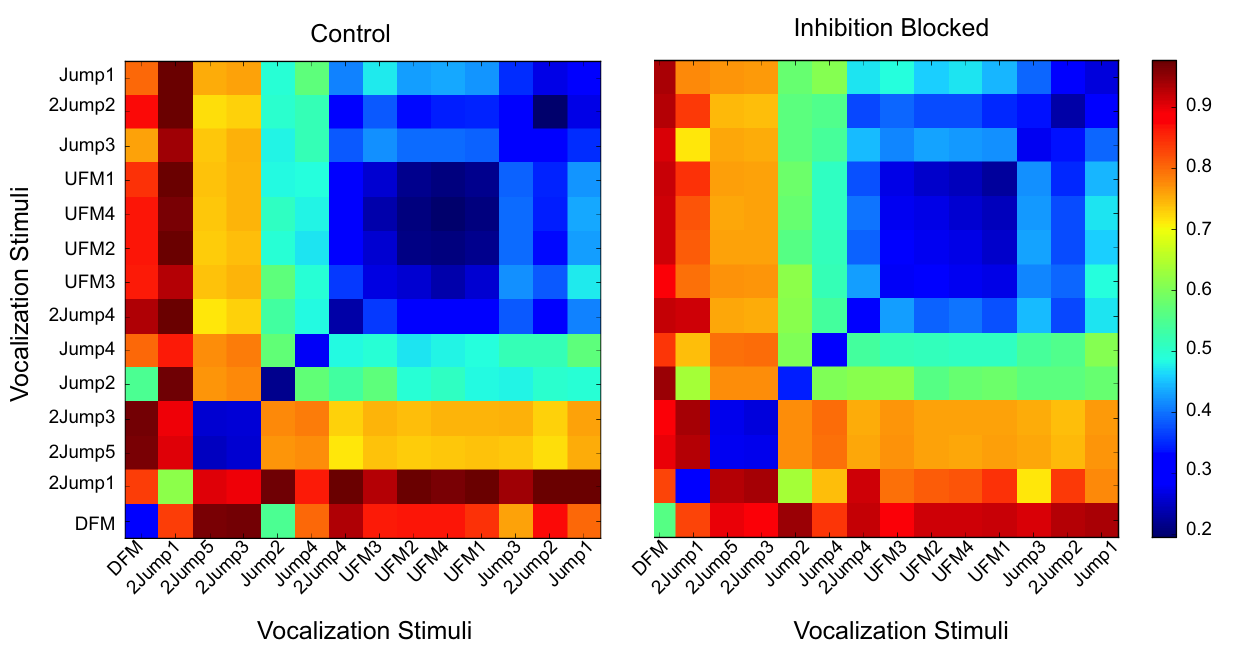
FIGURE 8 | Dissimilarity matrices for a broadly responsive neuron under control (left panel) and inhibition-blocked (right panel) conditions. An element in this matrix, D i , j , contains the average dissimilarity between neural responses to pattern i and the corresponding responses to patter j , as measured by the vdps measure. This broadly responsive pattern neuron could discriminate rough classes of vocalization stimuli (blue regions, small dissimilarities), with high dissimilarity between them (red regions,